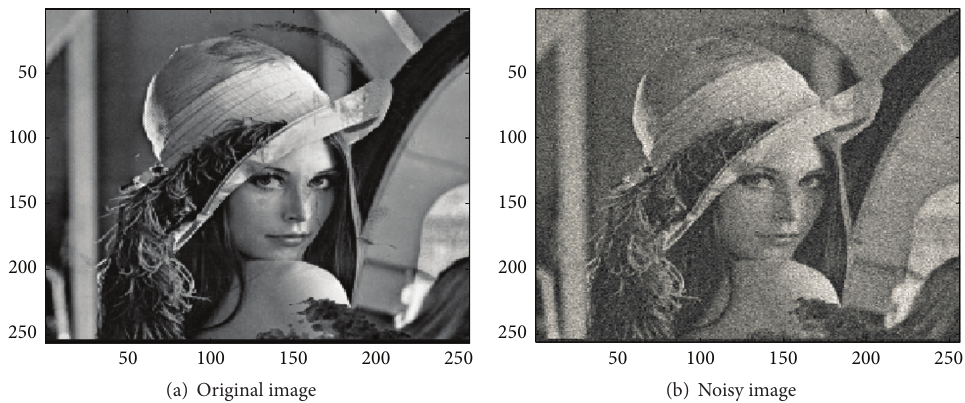
Figure 6: Gray Lean image and its contaminated version by 20% random